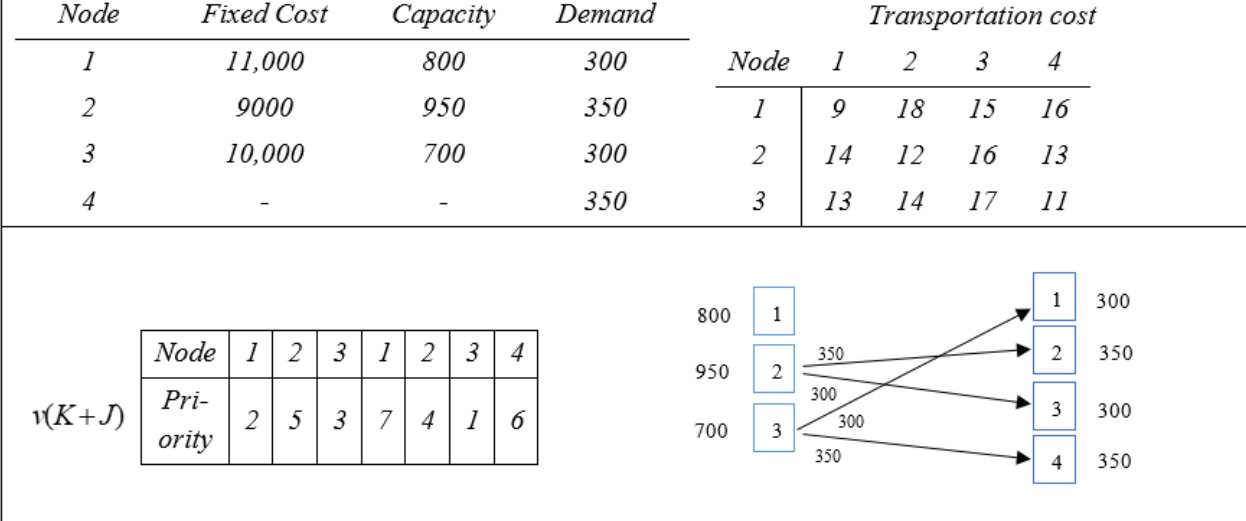
Figure 10. Decoding of initial solution.